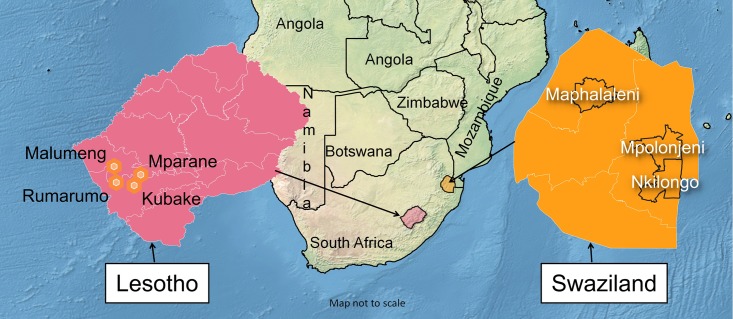
Map of study area.Map source: [65].